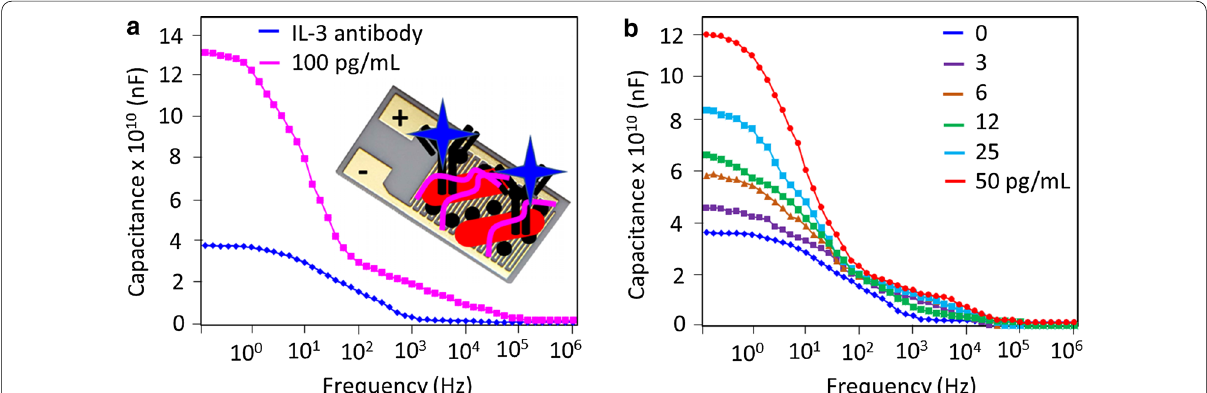
Fig. 4 Determination of IL-3 on the anti-IL-3-modified surface. a Identification of 100 pg/mL of IL-3. Clear changes in capacitance were noted after dropwise addition of IL-3. The figure inset displays the schematic. b Titration of different IL-3 concentrations onto anti-IL-3 antibody. With all concentrations of IL-3, capacitance changes were